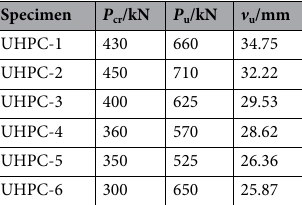
Table 4. Cracking load P cr , ultimate load P u and deflection v u of the specimens.